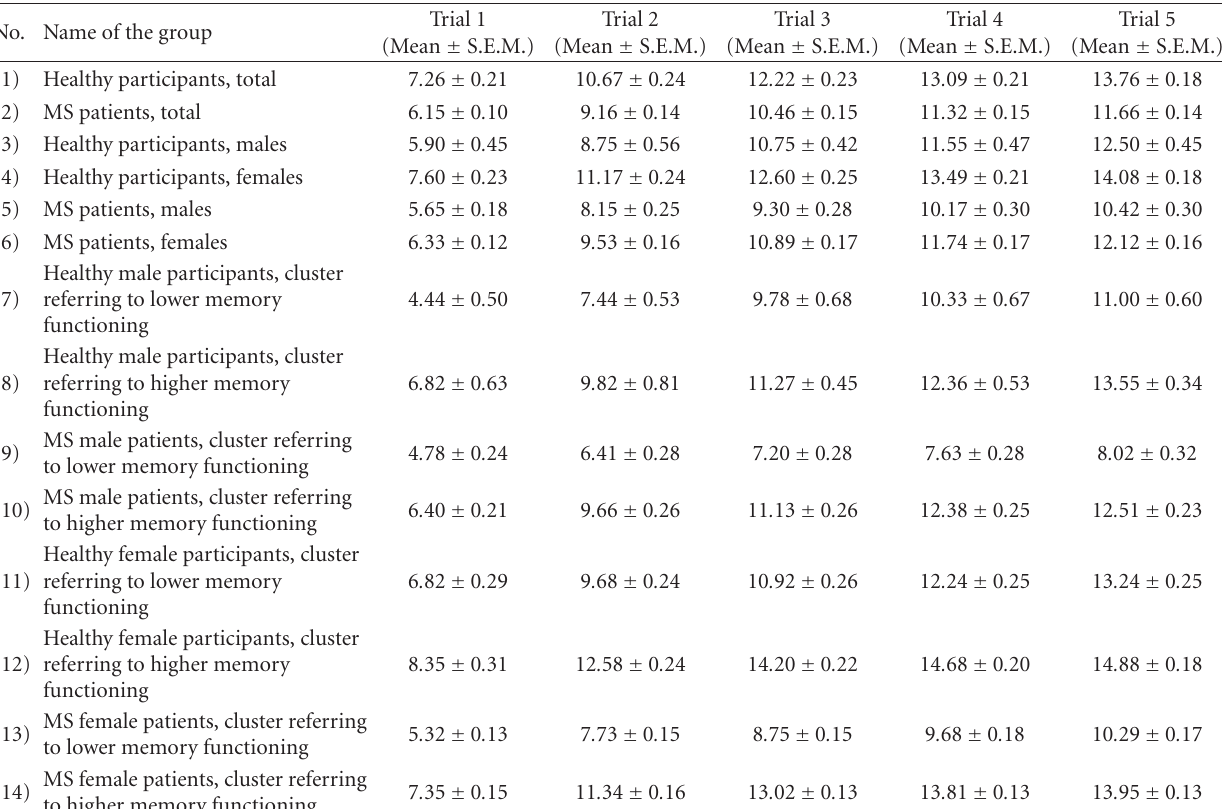
Table 1: CVLT-II immediate free recall learning